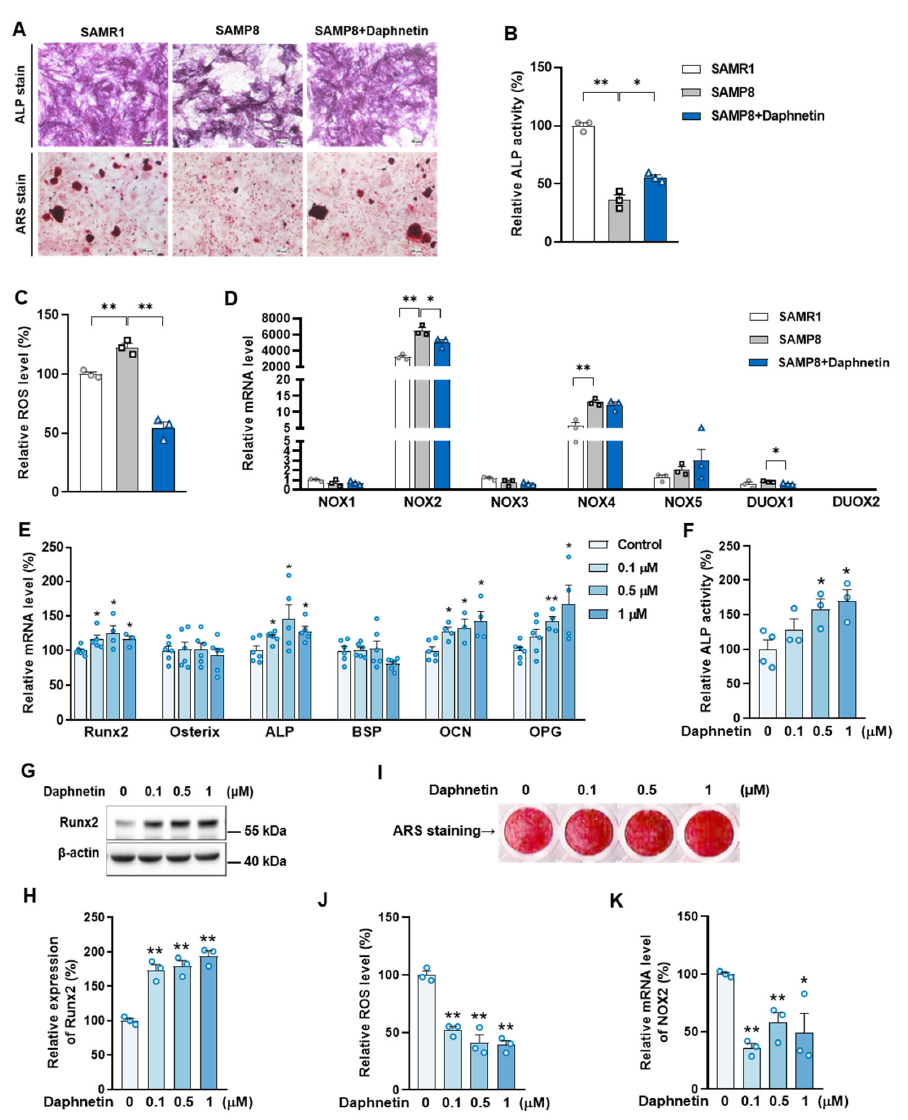
Figure 5. The decrease of ROS and inhibition of NOX2 in daphnetin-promoted osteogenesis. Primary osteoblasts were isolated from mice and induced differentiation in vitro. ( A ) ALP and ARS staining were performed and observed with microscope after differentiation for 7 days. ( B ) ALP activity in cell homogenate was determined after differentiation for 4 days. ( C ) Intracellular ROS level was determined with DCF probe after differentiation for 3 days. ( D ) The transcription of NOX family genes was determined by qRT-PCR after differentiation for 3 days. MC3T3-E1 cells treated with indicated concentrations of daphnetin were induced to differentiate in vitro. ( E ) The mRNA levels of bone formation-related marker genes were determined by qRT-PCR after differentiation for 2 days. ( F ) ALP activity in cell homogenates was determined after differentiation for 7 days. Expression of Runx2 was determined by Western blot (( G ) Western blot images; ( H ) statistical anal- ysis). ( I ) ARS staining was performed, and mineral deposition in cell matrix was photographed after differentiation for 14 days. ( J ) Intracellular ROS level was determined after daphnetin treatment for 24 h. ( K ) The mRNA level of NOX2 was determined by qRT-PCR after differentiation for 2 days. Data are mean ±S.E.M. ( n ≥ 3); * p < 0.05; ** p < 0.01 between the connected groups or versus control.